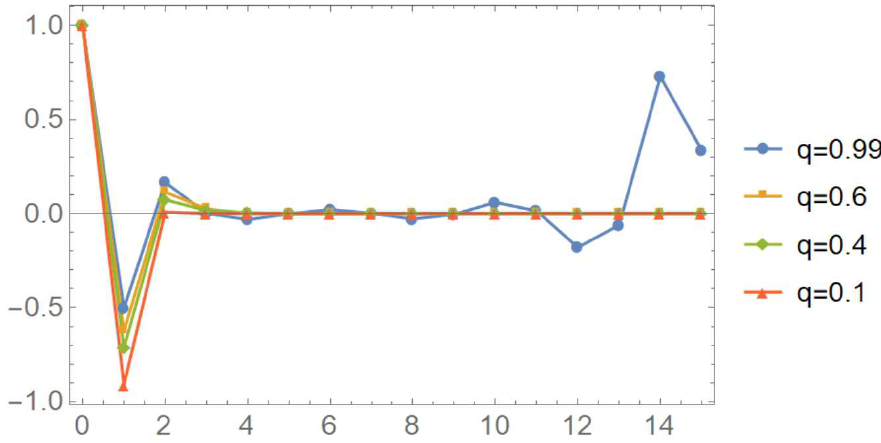
Figure 1. In Figure 1, nonnegative integers of the x -axis represent the value of n .